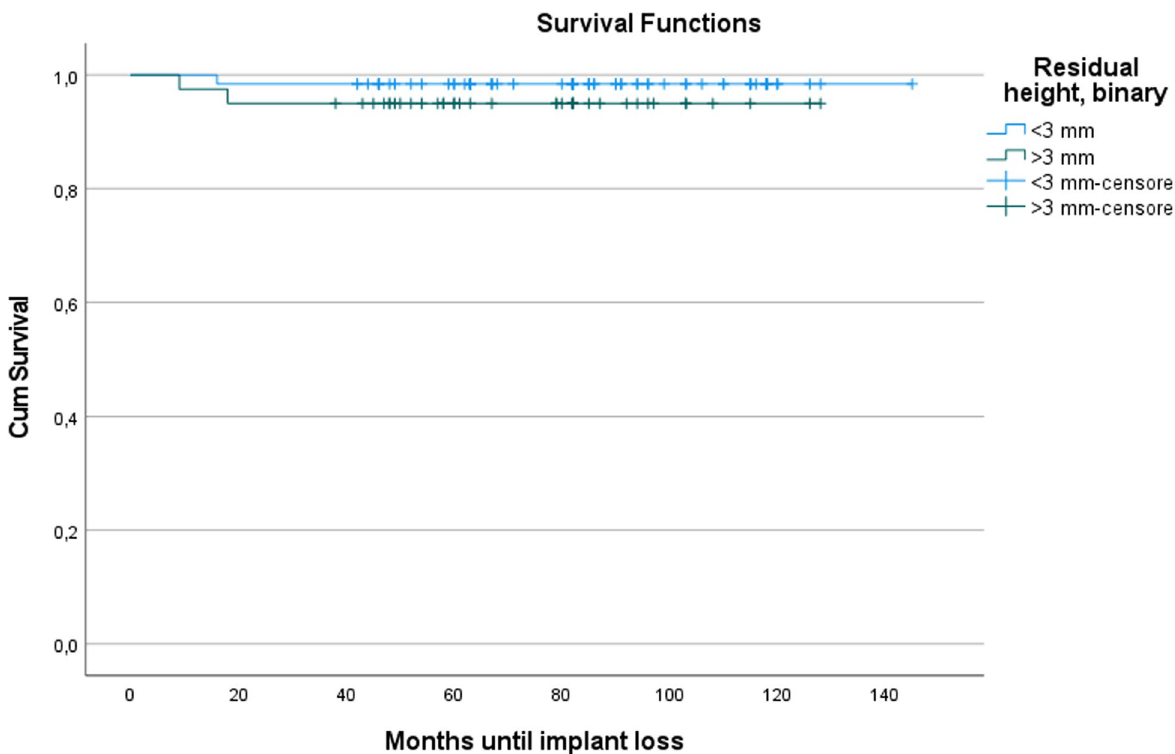
Fig. 6 Kaplan–Meier survival curve for the probability of implant loss depending on the residual height of the alveolar ridge (< 3 mm or The time in months after augmentation and simultaneous implant placement was plotted on the abscissa. The ordinate indicates the cumulative survival probability, i.e., the probability that no implant loss